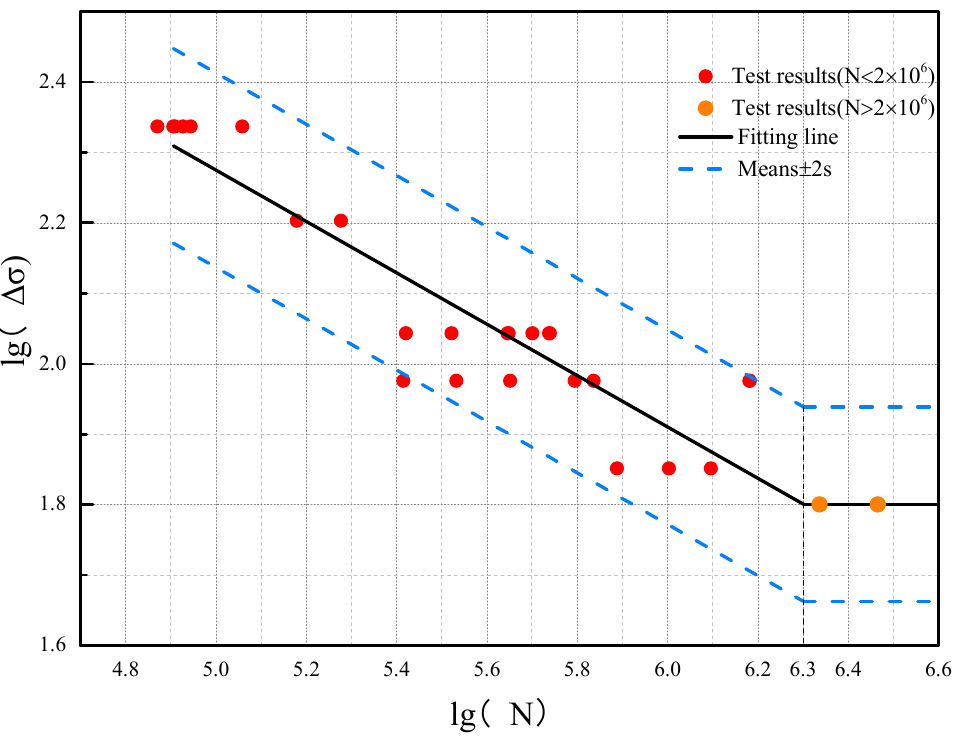
Figure 7. The variation of log (Δσ) with log ( N ): The log–log plot of the M60 high-strength bolt’s S–N curve.